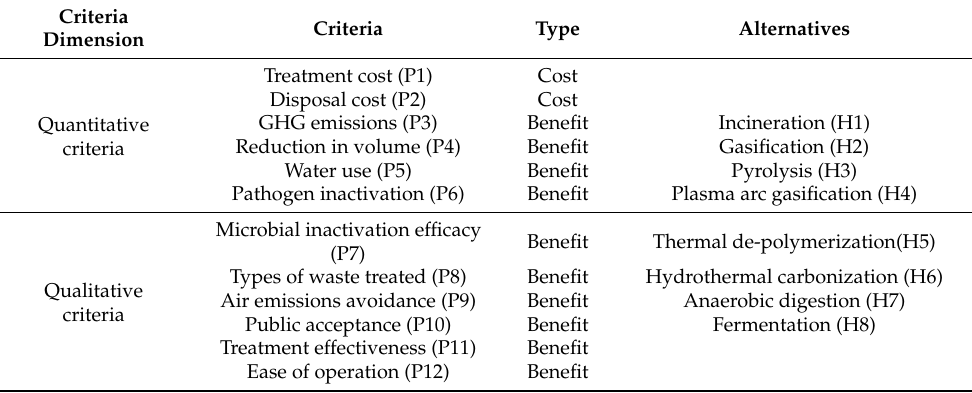
Table 2. Assessment criteria for the WTE technology selection for MSW treatment. Criteria